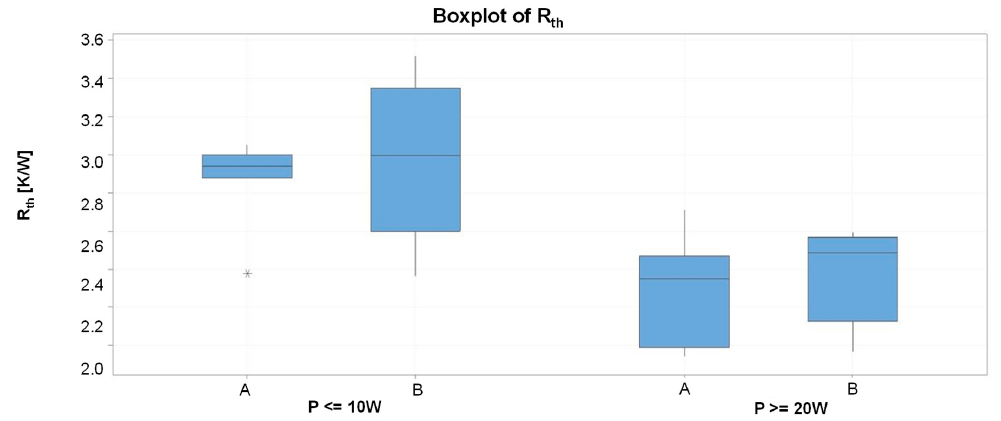
Figure 20. Distribution of R th measurement results for the TRA transistors (marked as A) type BLC10G22LS-240PVT and the TRB transistors (marked as B) type BLC9G22LS-160VT in the tested PCB1–PCB4 modules.